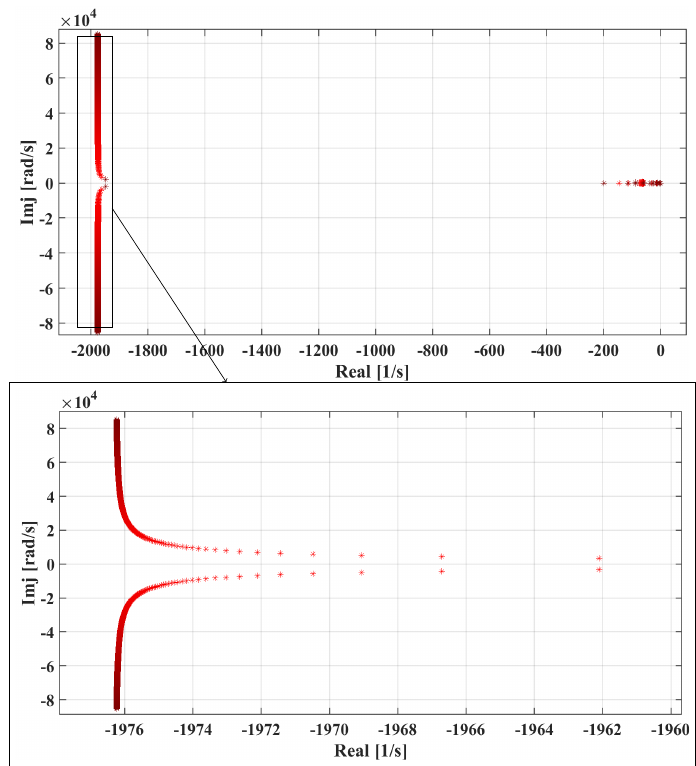
Figure 10. Eigenvalues with varying the Kw inertial